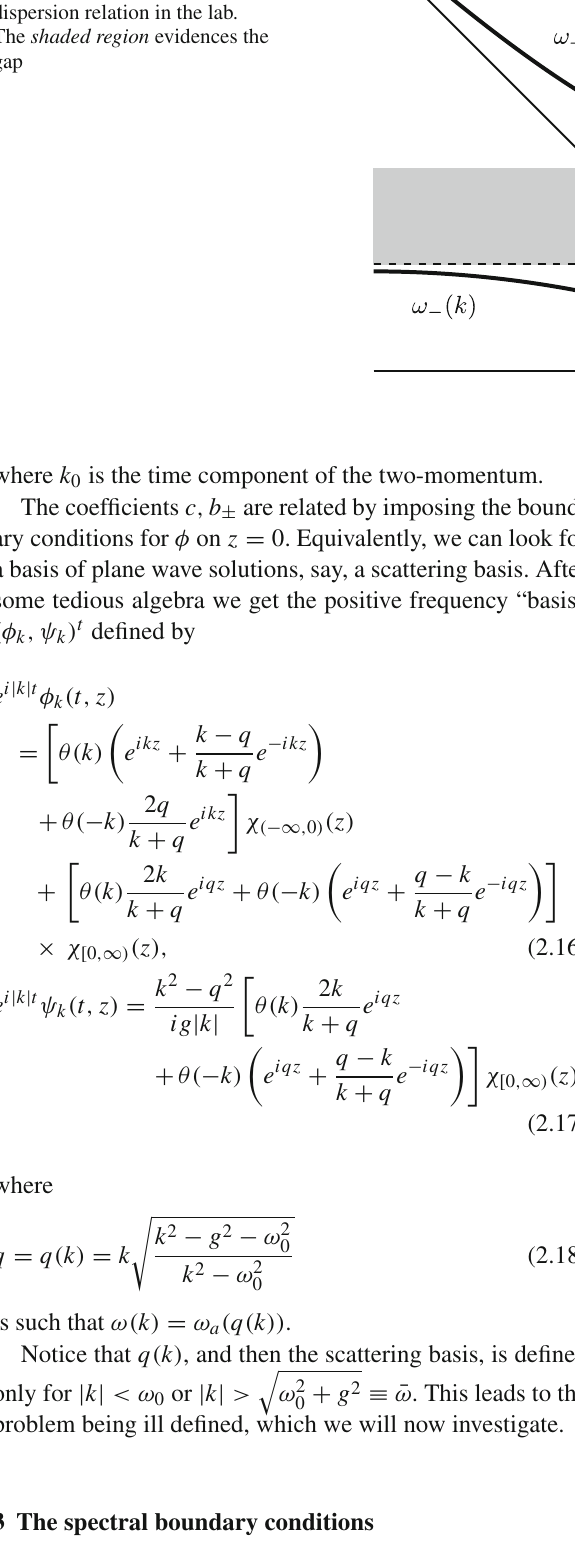
Fig. 1 The Sellmeier dispersion relation in the lab. The shaded region evidences the